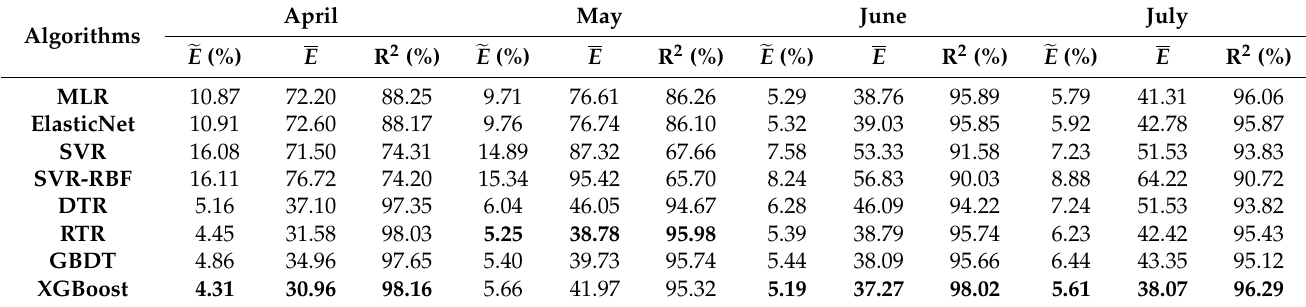
Table 3. Accuracy of algorithms.